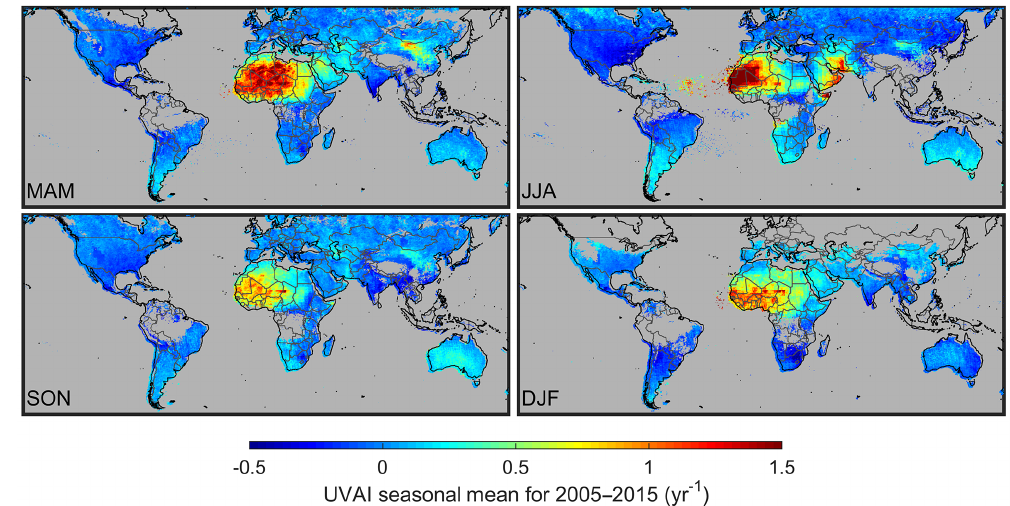
Figure 3. Seasonal mean UVAI values for the 2005–2015 period from our simulation coincidently sampled from OMI for MAM (May, April, March), JJA (June, July August), SON (September, October, November), and DJF (December, January, February). Grey indicates persistent cloud fraction greater than